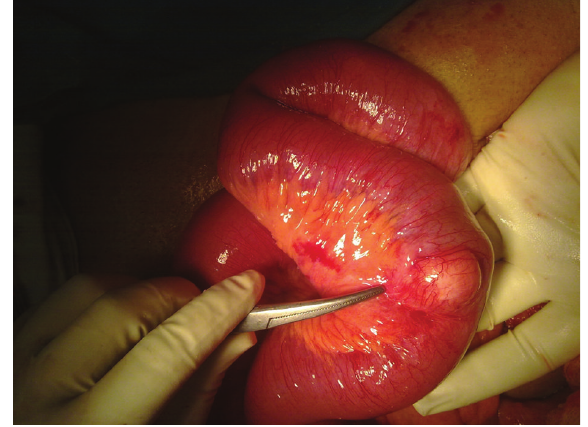
Figure 2: Externally visible tumor which served as a lead point. Note that the bowel is healthy, and mesenetry has no lymph